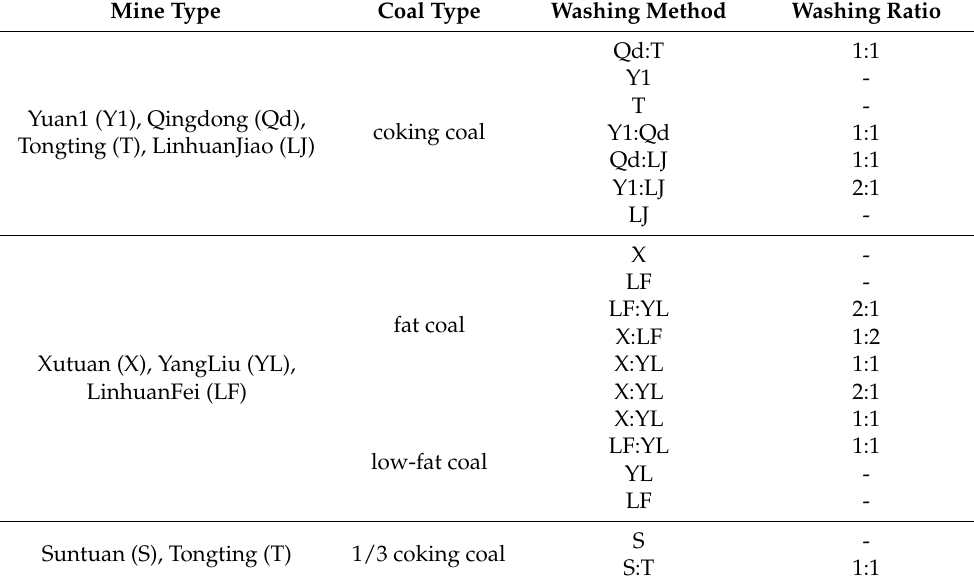
Table 8. Coal blending and washing methods in the production